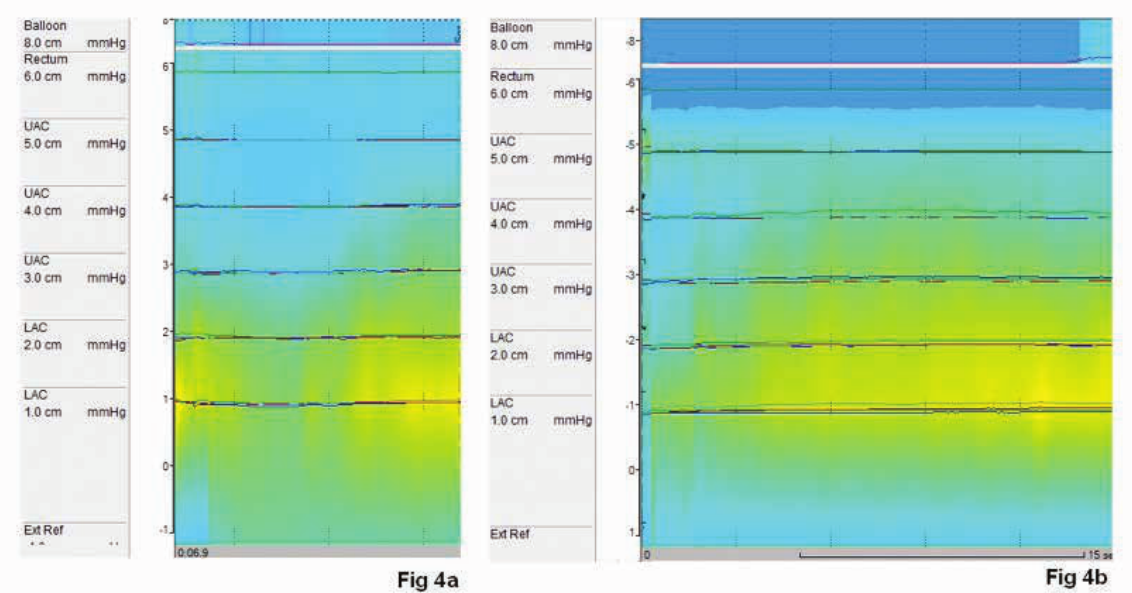
Figure 4: Pre FMS treatment (a) and post FSM treatment (b) HRAM (High Resolution Anal Manometry) showing no significant sphincteral